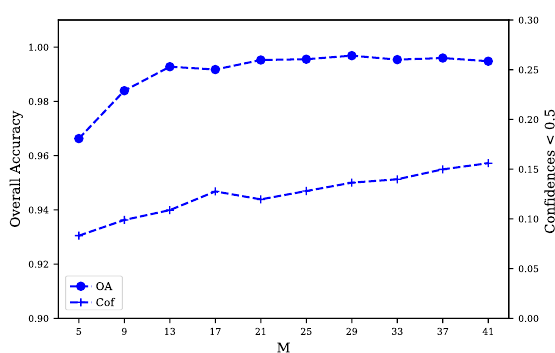
Figure 6. Overall accuracy and Uncertainty as a function of M based on 2D-CNN